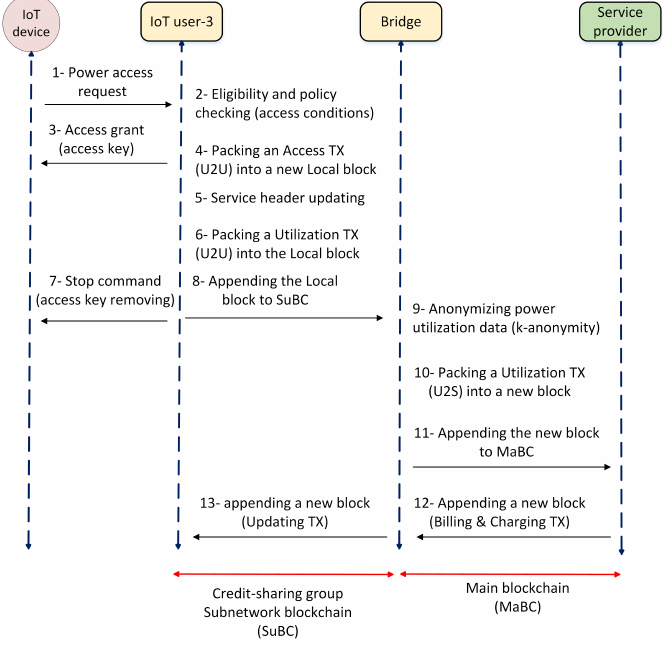
Figure 6. Power access and utilization transaction